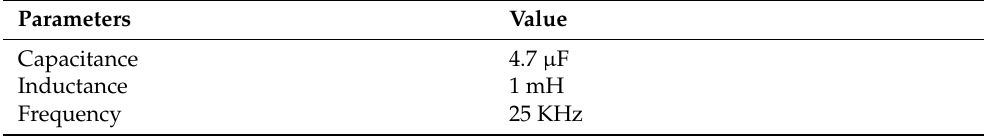
Table 2. Parameters of the